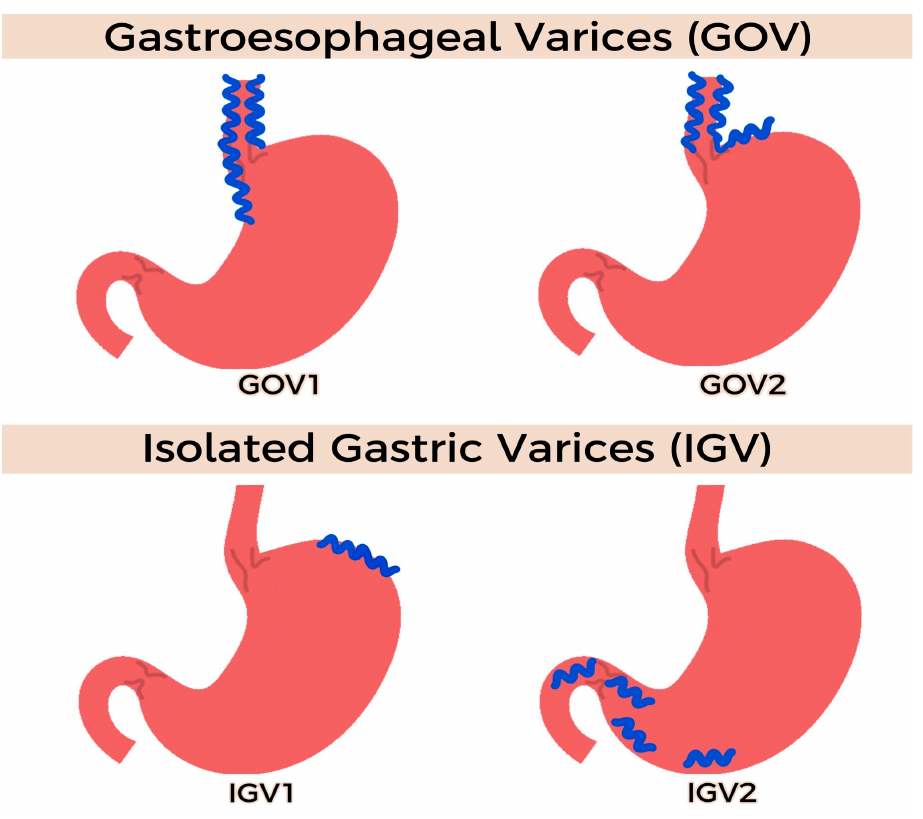
Figure 3. Sarin classification of gastric